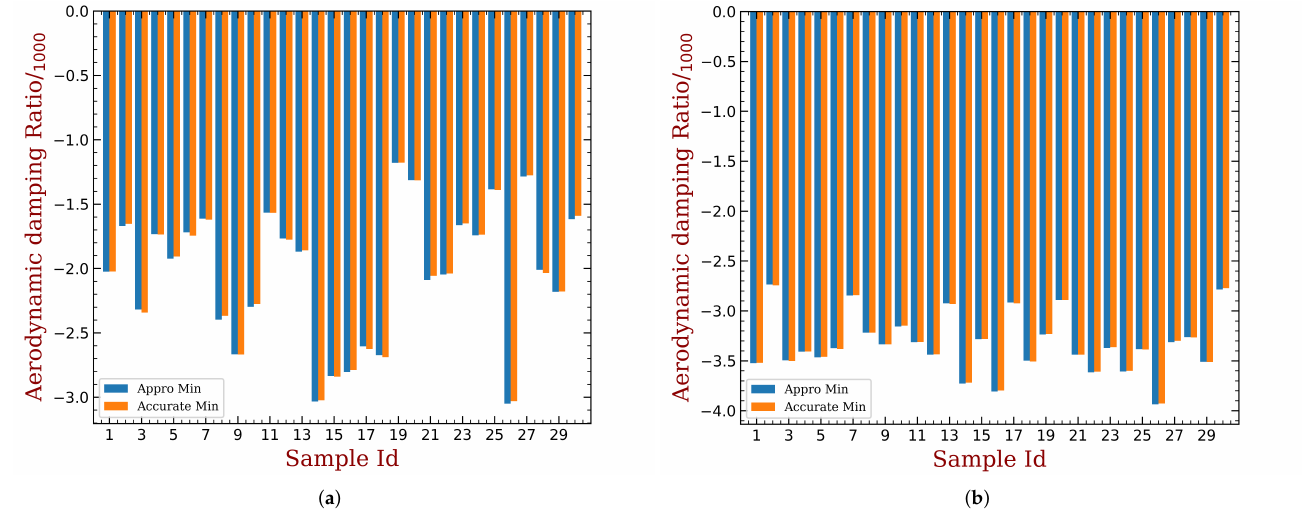
Figure 12. Reconstructing the least aeroelastic damping with random mistuning, with 30 of 1000 samples shown for each case. ( a ) Standard deviation 0.2%, ( b ) standard deviation